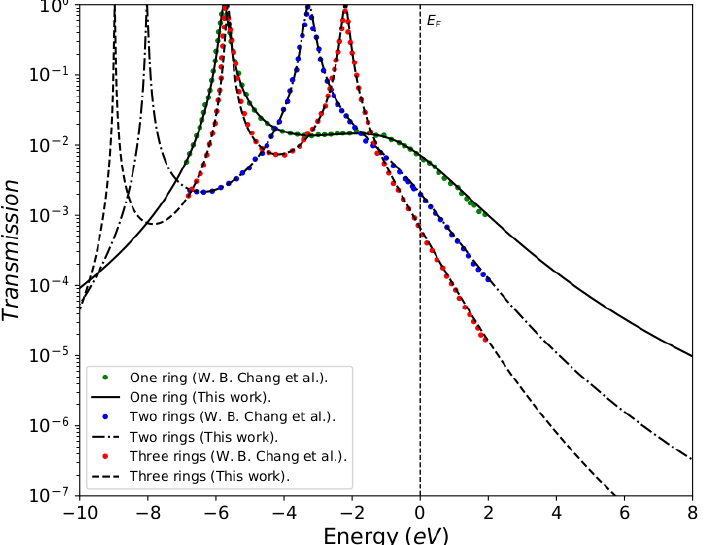
Figure 3. Transmission probability T ( E ) as a function of the injection energy of the electron E , for the molecular systems with one, two, and three thiophene rings for the values: Γ = 5.32 eV, E b = − 5.54 eV, E s = − 0.98 eV, δ = − 2.40 eV and τ = − 0.83